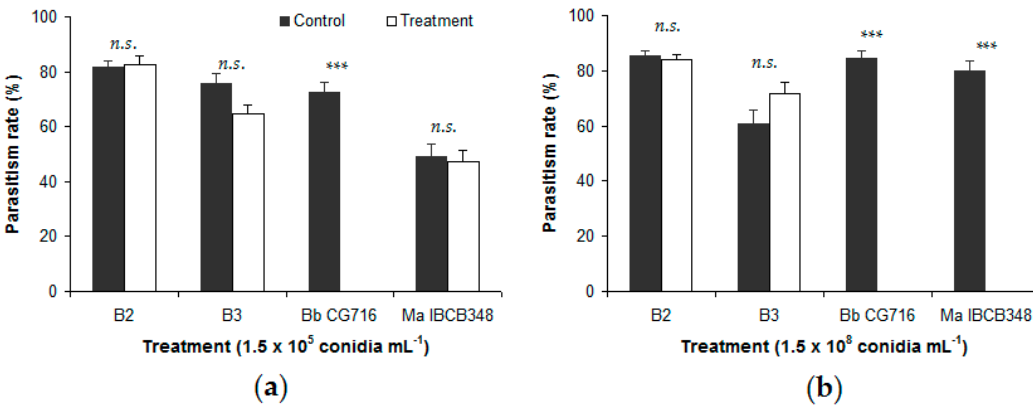
Figure 2. Percentage of Duponchelia fovealis eggs parasitized by Trichogramma pretiosum in free-choice tests, comparing eggs sprayed with Beauveria bassiana strains (B2 and B3) and commercial bioinsecticides (Bb CG716 and Ma IBCB348) vs. control solutions: ( a ) 1.5 × 10 5 conidia mL − 1 ; ( b ) 1.5 × 10 8 conidia mL − 1 . Error bars indicate standard errors (n = 15). Significant differences between a given treatment (entomopathogen) and its corresponding control (water), according to the Wilcoxon test, are shown over the bars as follows: n.s. = not significant; *** = p -value < 0.001. No significant differences were detected between either B. bassiana strain and the respective control in the percentage of eggs parasitized, except for B3 at 1.5 × 10 5 conidia mL − 1 in the presence of